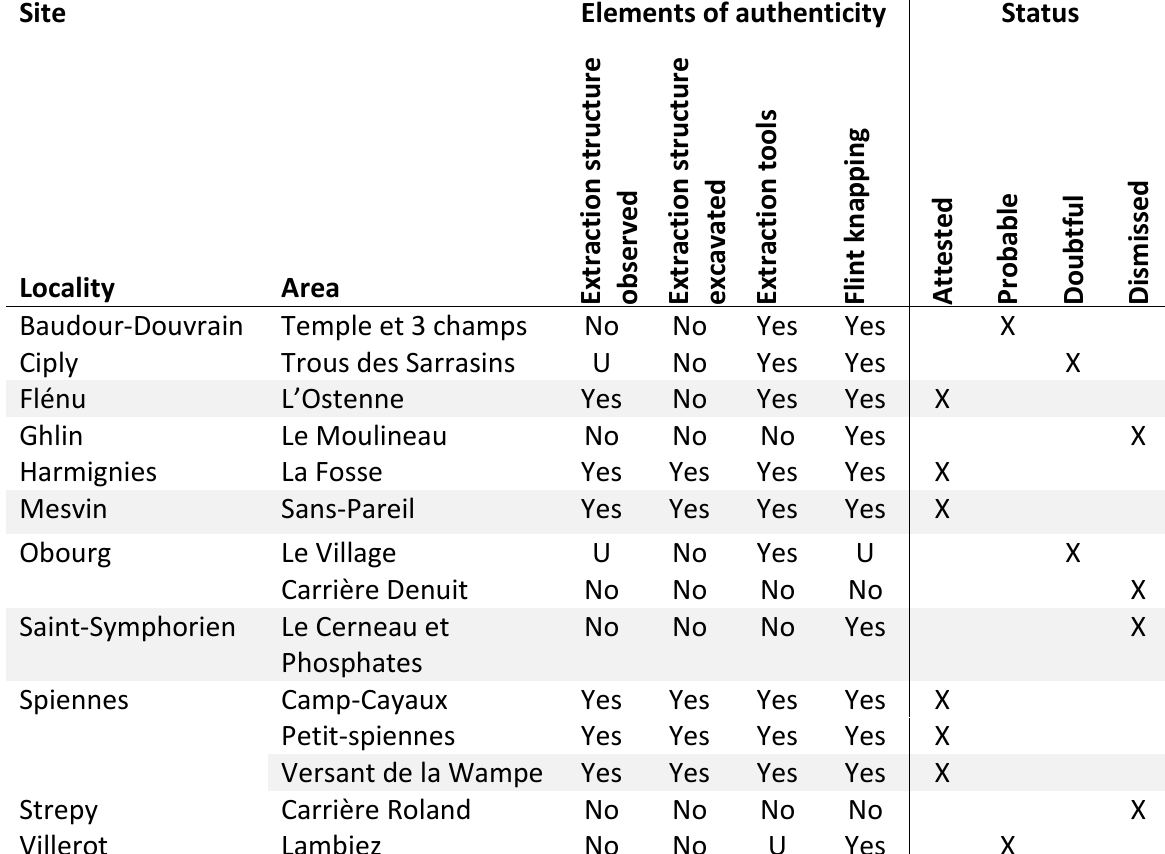
Table 1. Critical analysis of extraction sites in the Mons Basin. The three areas of Spiennes are considered as parts of a single site isolated by natural element such as the La Trouille valley. Abbreviations: U - elements that are mentioned in literature but which are